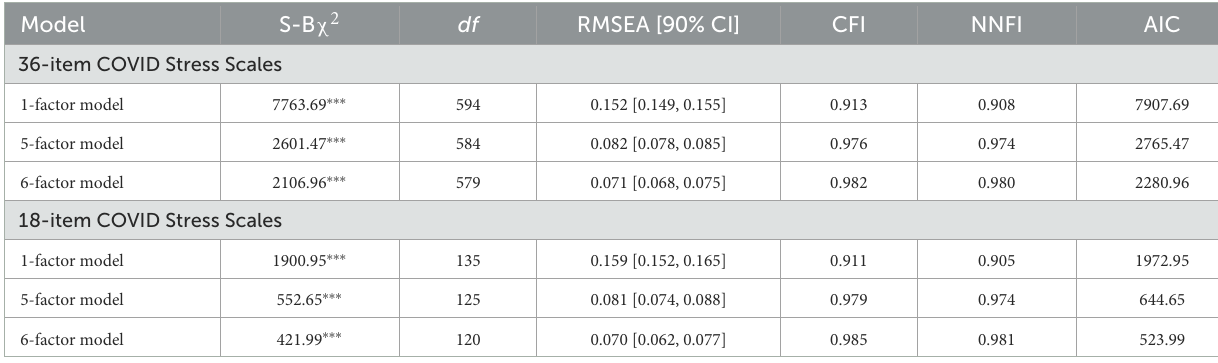
TABLE 1 Confirmatory factor